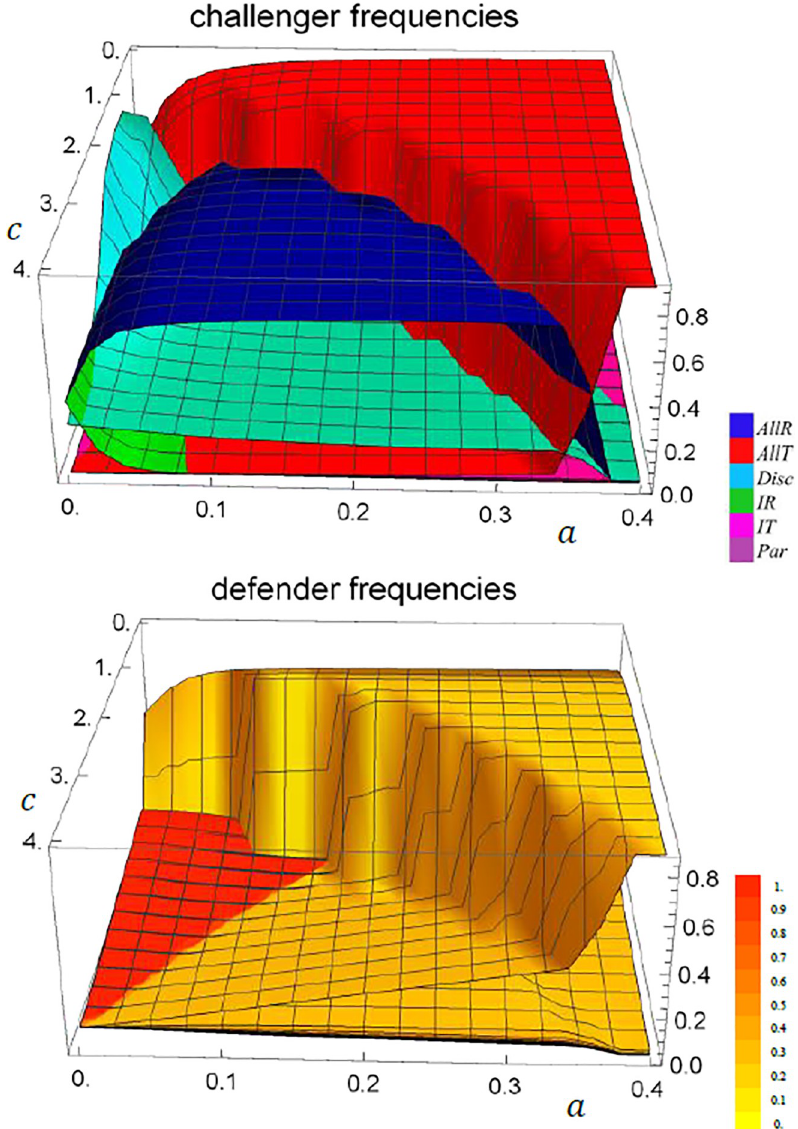
Fig 6. Long term challengers’ and defenders’ strategy frequencies if reputations are determined by last-action. If the costs c of fighting are low, deterrence fails and takers and yielders prevail. For high fighting costs, most challengers respect and deterrence is able to evolve. For intermediate fighting costs deterrence can also be based on discrimination if information costs are very small. Successful deterrence leads to low selection pressure for defender strategies and fighting probabilities vary widely. Parameter values: v = 1, N = 10 4 , N = 100, d = 0.9, u = 10 − 2 , μ = � = δ = 10 − 3 . F Frequencies are averaged over rounds 8000 − 10000 from 100